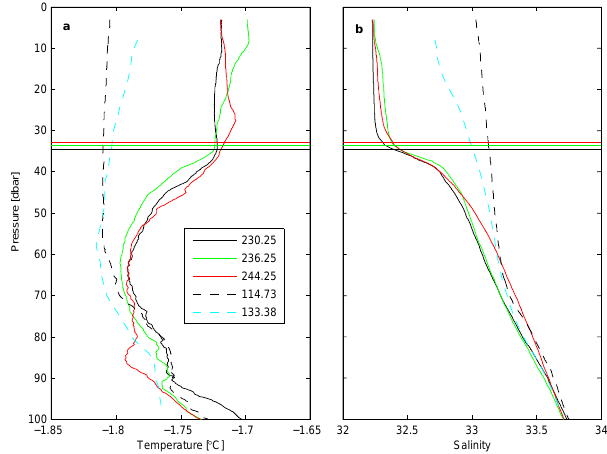
Fig. 5. Depth profiles (upper 100m) of (a) temperature and (b) salinity for the start, middle and end of the drift, for the end of the Borneo08 experiment (doy 114) and from the ITP19 pro- filing buoy (doy 133). ASCOS profiles are averaged over a 24-h period, centred at the time given in the legend. Barneo08 profiles are the averages of the 10 last profiles during the experiment and ITP19 profiles are the averages of all single profiles obtained within the latitude and longitude ranges defined by the ASCOS drift. Hor- izontal lines indicate the depth of the mixed layer for the average